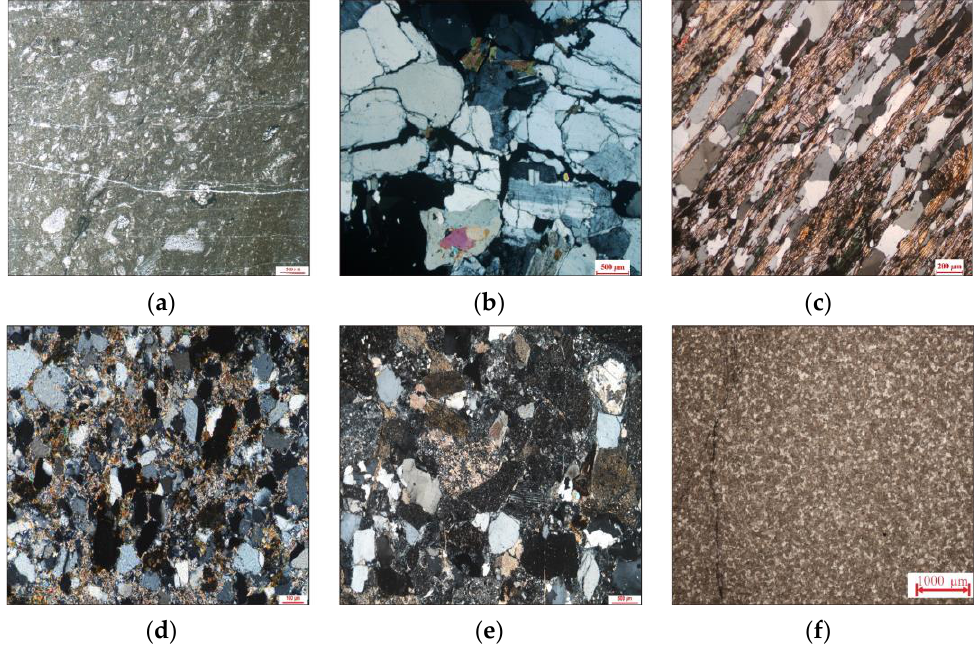
Figure 14. Prediction results of partial images on the test set; ( a ) wackestone; ( b ) granite; ( c ) schist; ( d ) quartz sandstone; ( e ) conglomerate; ( f ) crystalline dolomite.